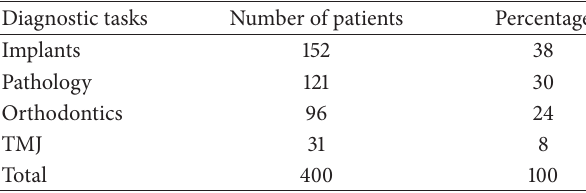
Table 1: Indications for CBCT